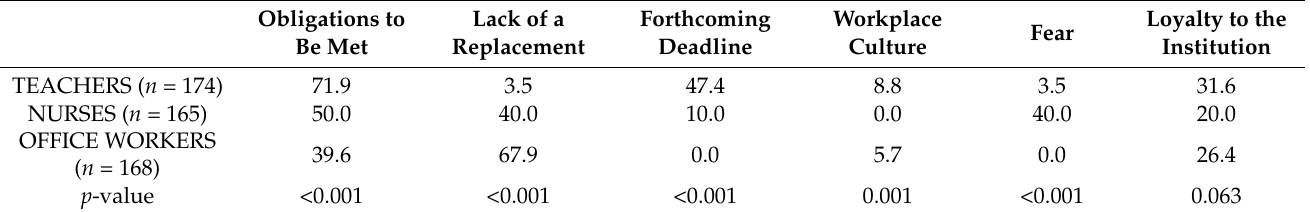
Table 4. Distribution of responses (%) and p -values for the chi-squared test concerning the reasons for which respondents attended work when sick or presenting with health